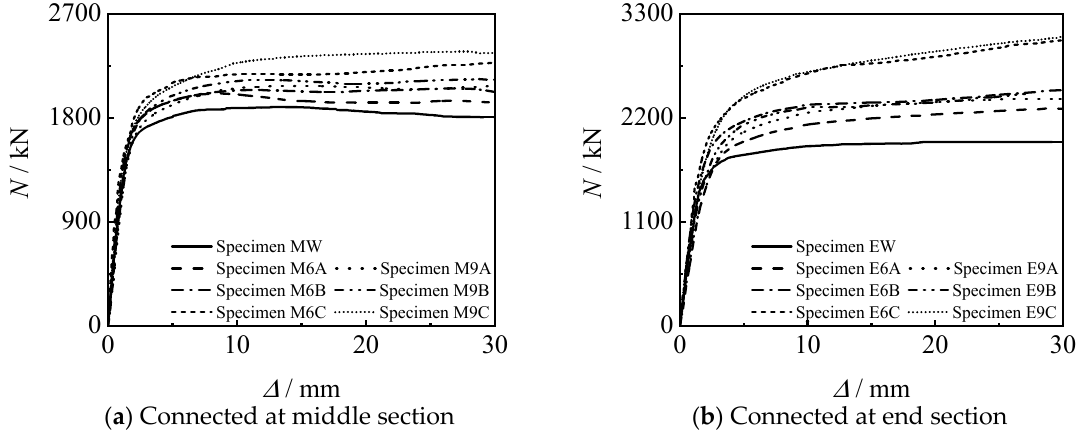
Figure 10. N- Δ curves of connected specimens.